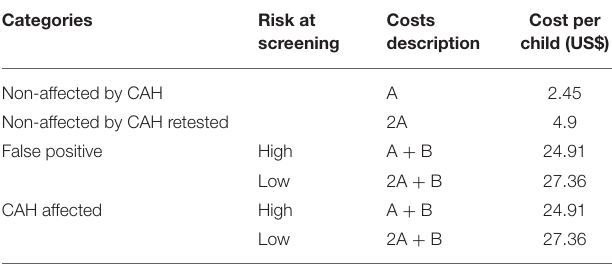
TABLE 1 | Costs for different categories after CAH screening until the age of 1 year